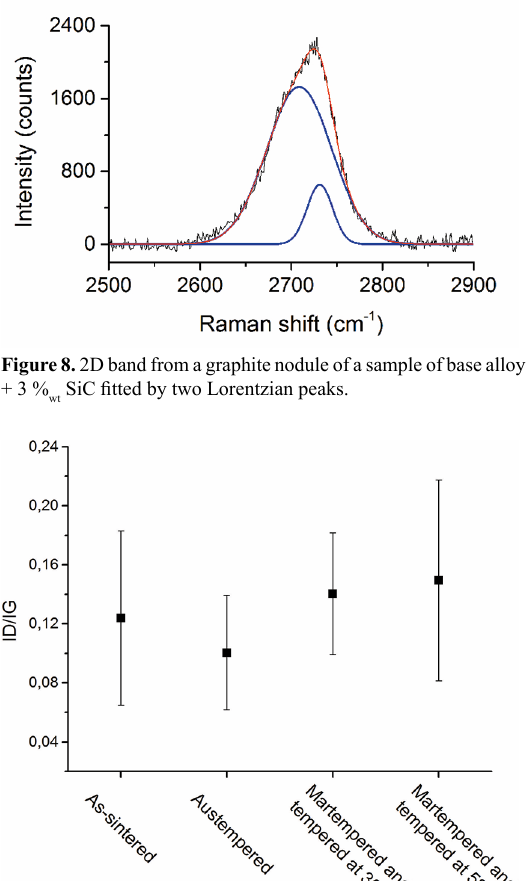
Figure 9. ID/IG ratios for samples of base alloy + 3 % as-sintered and heat-treated conditions. structure of the graphite derived from SiC dissociation 10 thus maintaining its ability to provide solid lubrication 16